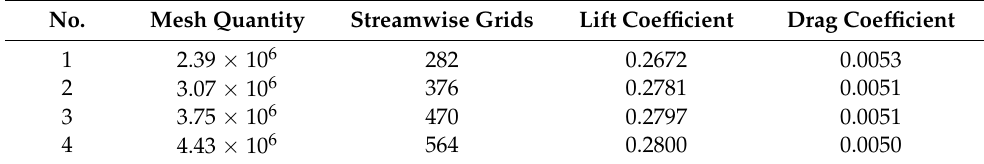
Table 1. Independence test of